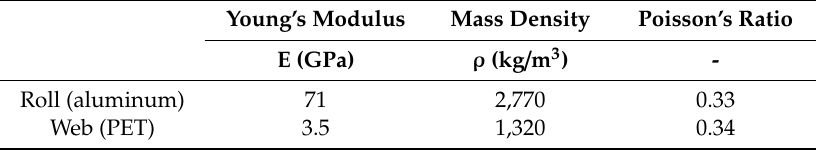
Table 1. Mechanical properties in the finite element analysis (FEA).